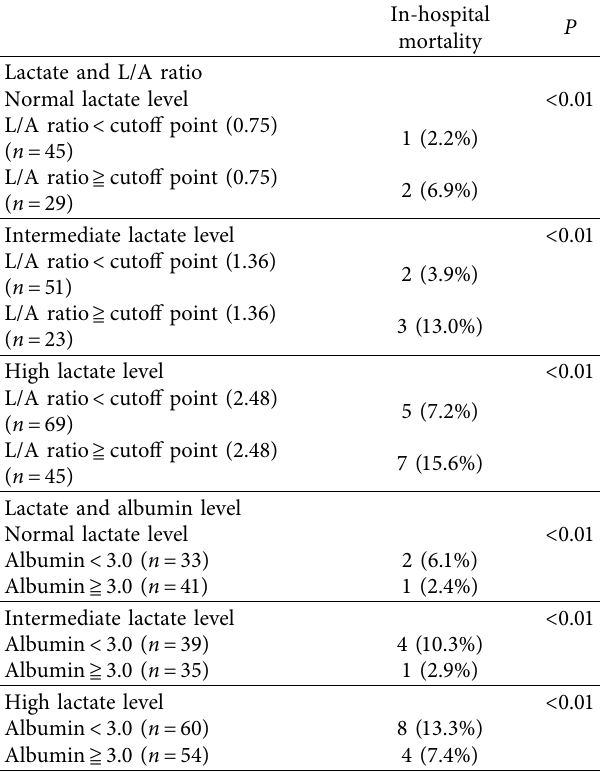
Table 3: In-hospital mortality according to lactate level, lactate/ albumin (L/A) ratio, and albumin level.